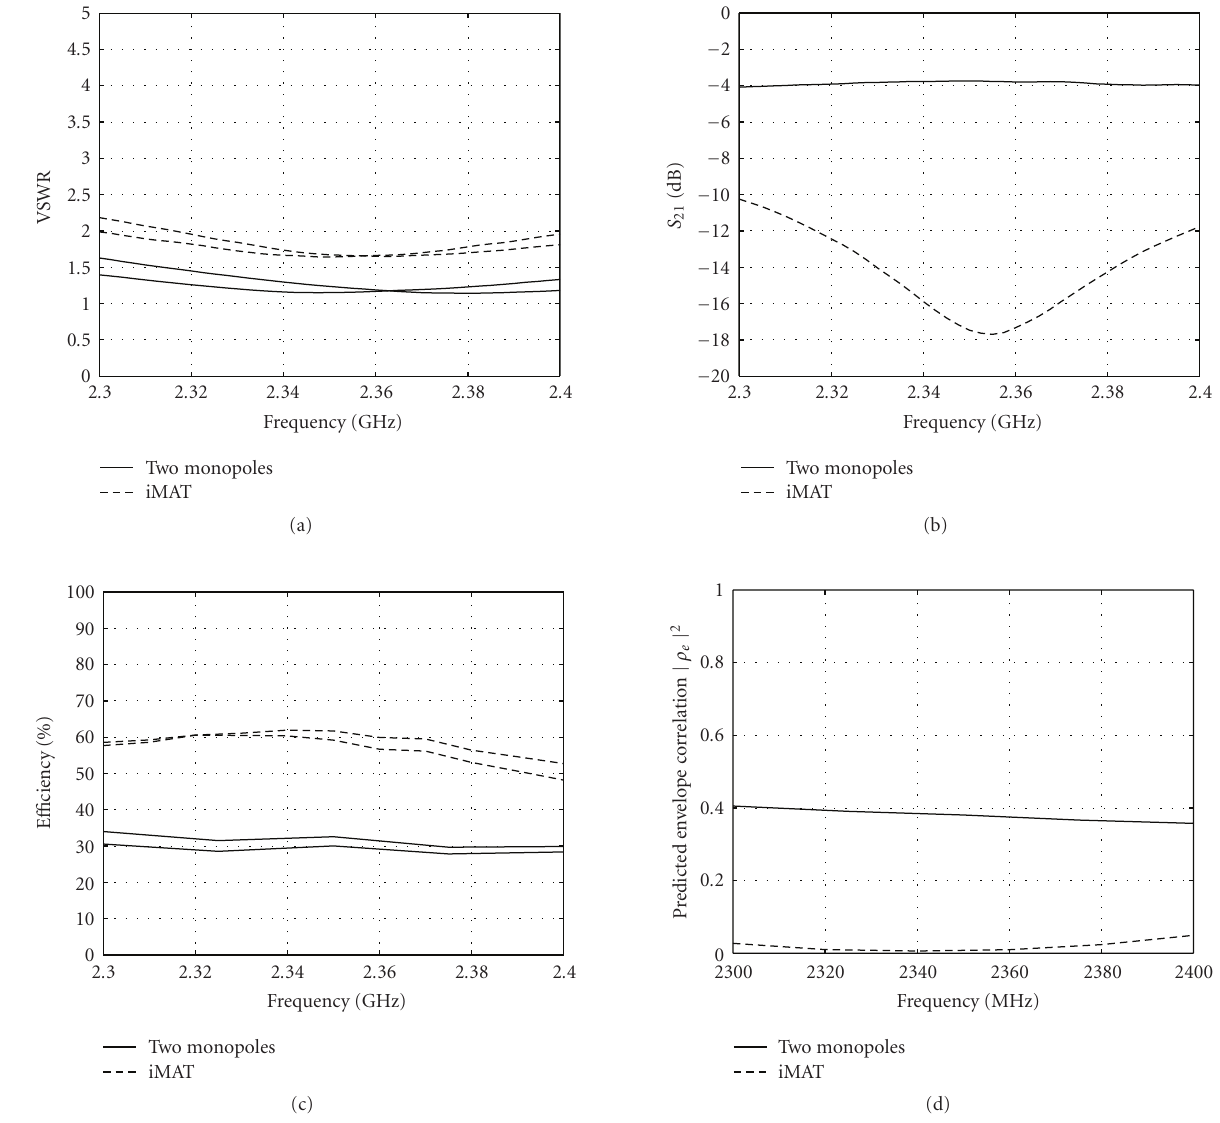
Figure 4: Comparison of (a) VSWR, (b) S 21 , (c) radiation e ffi ciency, and (d) envelope correlation coe ffi cient for 2 cases: two monopoles and iMAT antenna over the frequency range from 2.3 to 2.4